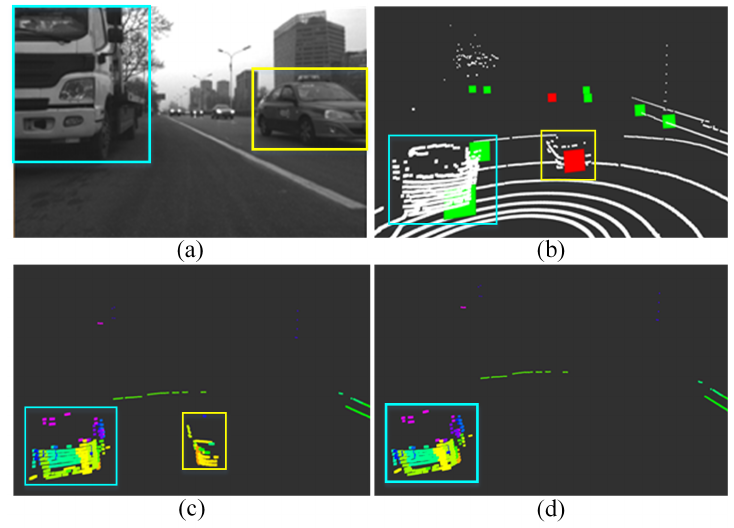
Figure 7. Moving targets detection and removal test. ( a ) Test scenario, two targets are detected by radar. ( b ) Stationary truck (green) and moving cars (red) are distinguished by radar after velocity compensation. ( c ) Segmentation result of point cloud. ( d ) Filtered point cloud.